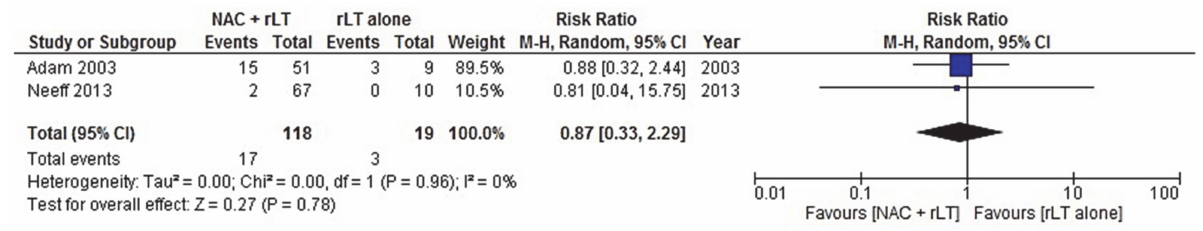
Figure 3. NAC + rLT versus rLT alone: one-year OS.